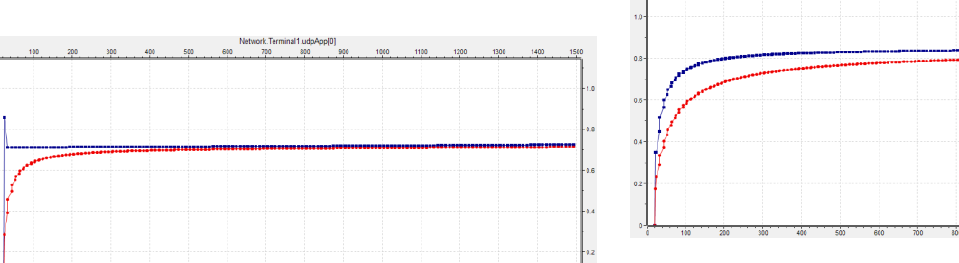
Figure 8. Satellite-earth link channel packet arrival